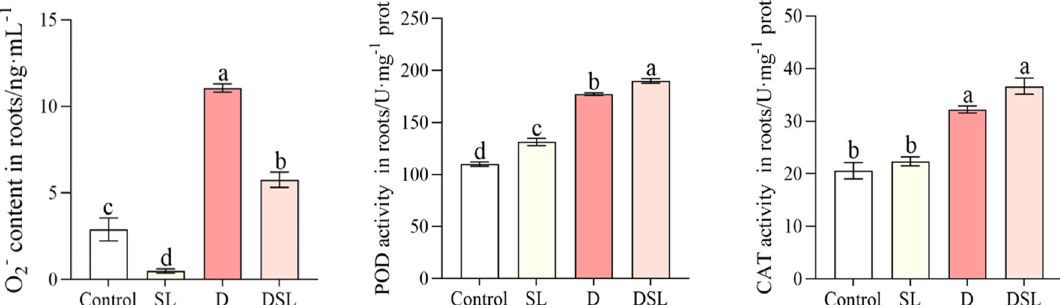
Figure 5. The content of O 2 − , POD, and CAT activities of alfalfa root in response to different treatments. Results are presented as the mean of four independent experiments ± standard error. a − d Dif- ferent superscripts mark significant differences between the treatments ( p < 0.05).